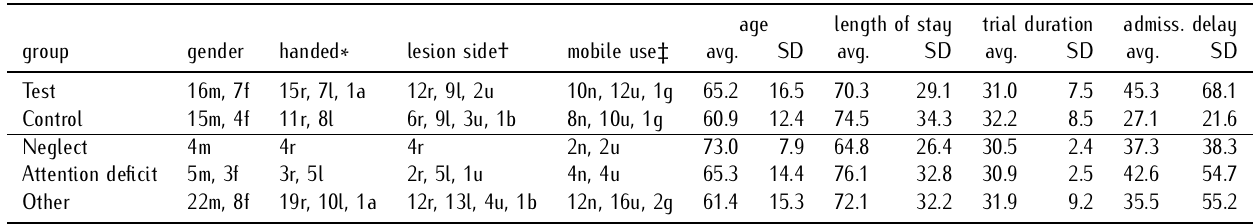
Table 2. Demographic and control variables data of the 42 finishing participants tallied by a) test and control group, and b) the three conditions: four USN (three in test and one in the control group), eight attention deficit (three test, five control) and 30 patients with no apparent deficits (seventeen test, thirteen control).